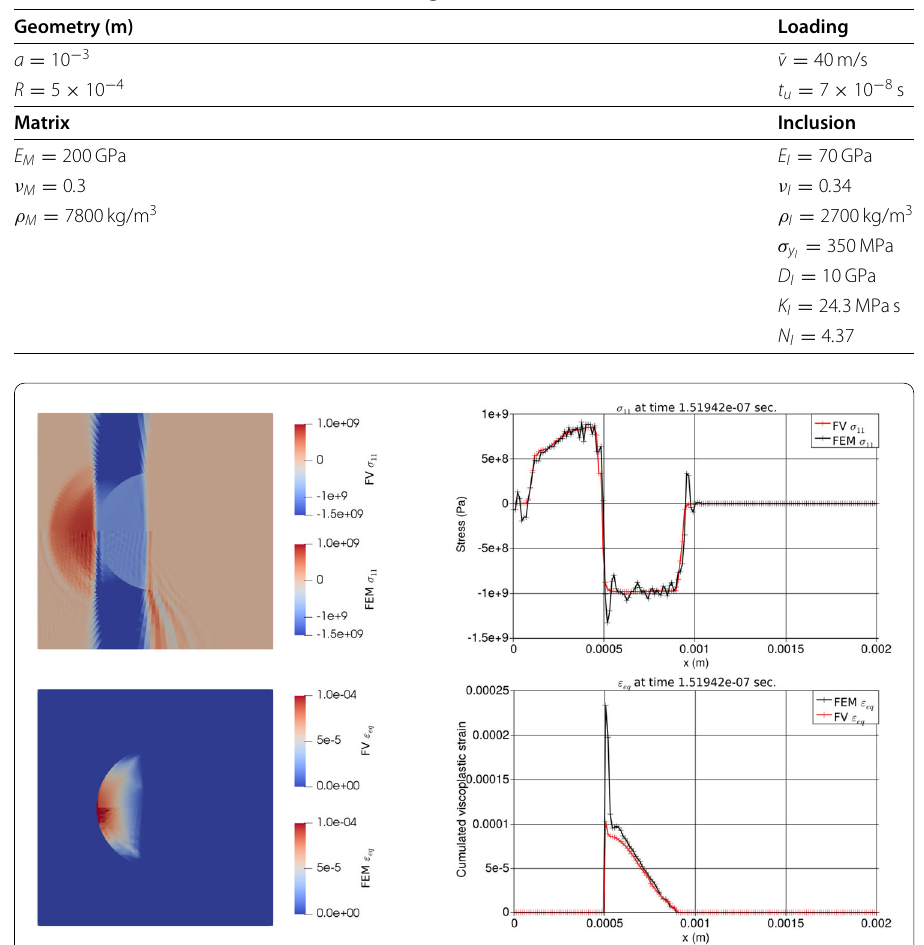
Table4 Parameters values for the heterogeneous volume test case